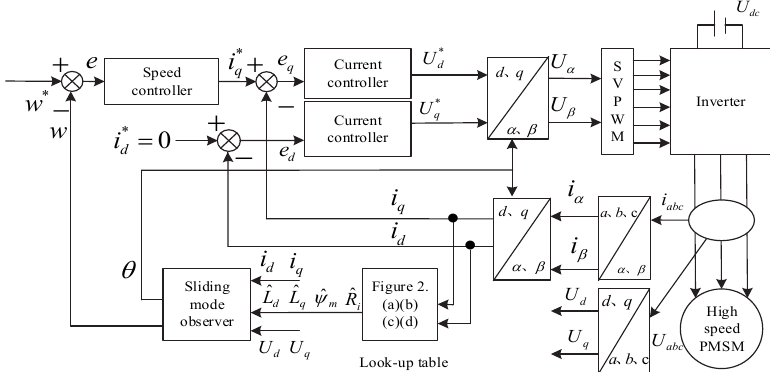
Figure 3. Overall structure block diagram of high ‐ speed motor vector control.